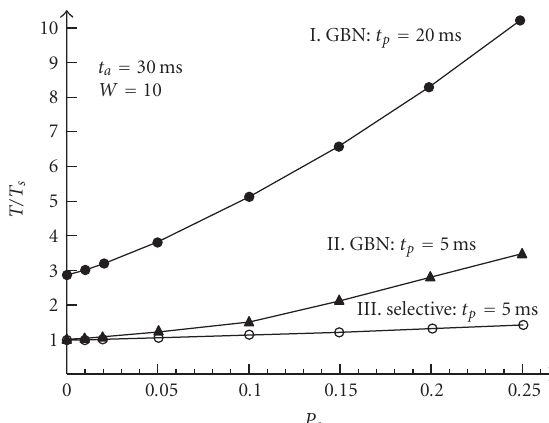
Figure 3: Normalized time of sending a series of blocks under Go- Back-N and selective